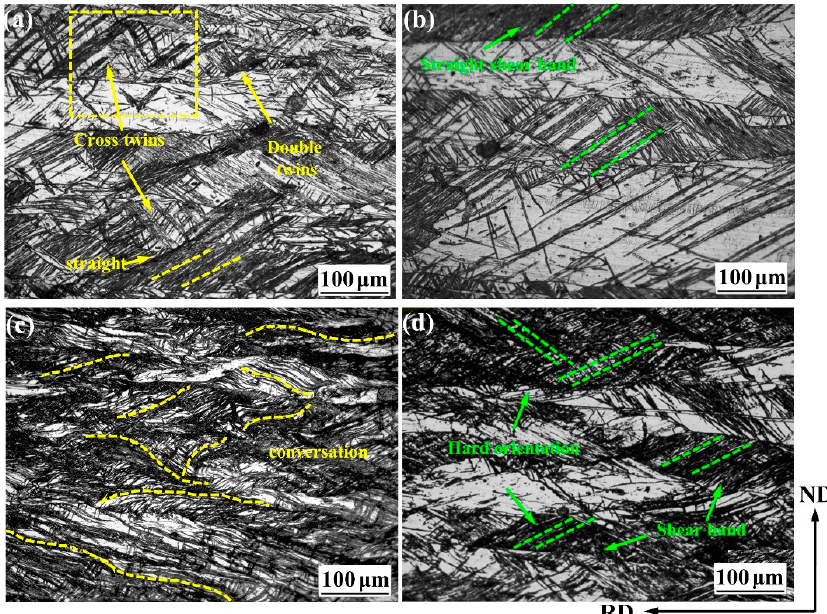
Figure 2. Metallographic microstructure of ( a ) CR30%, ( b ) RR30%, ( c ) CR50%, and ( d ) RR50%. Figure 3 is a metallographic diagram of the local organization of RR30% and RR50%.